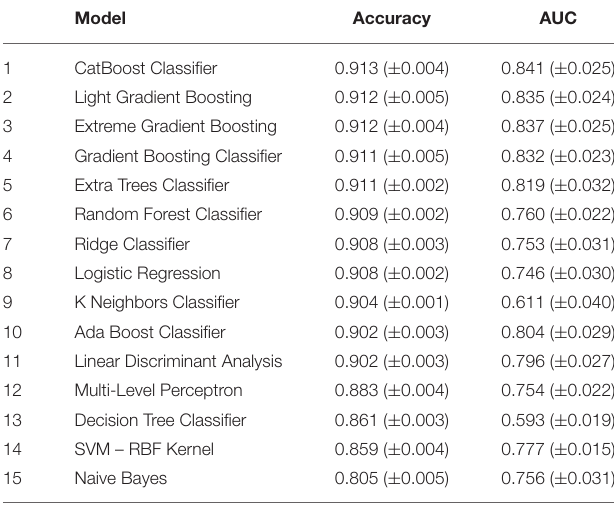
TABLE 1 | Performance of different models in internal